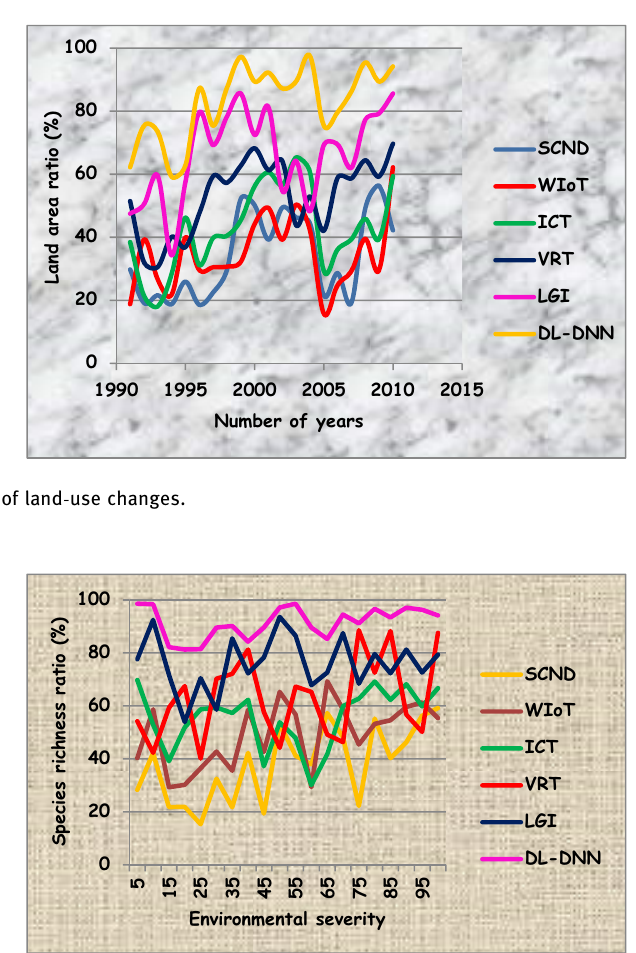
Figure 12: E ff ect of environmental.